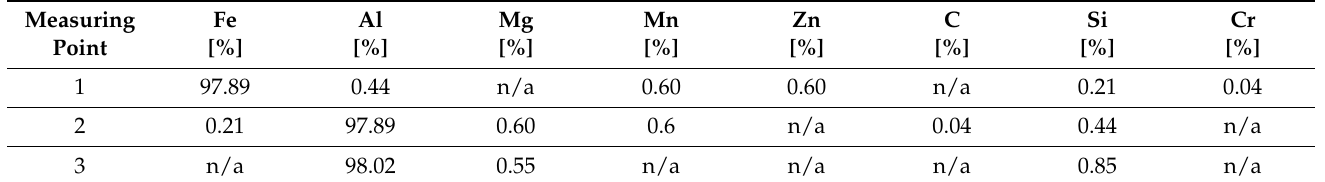
Table 3. Presentation of the results of the XRF hand-spectrometer